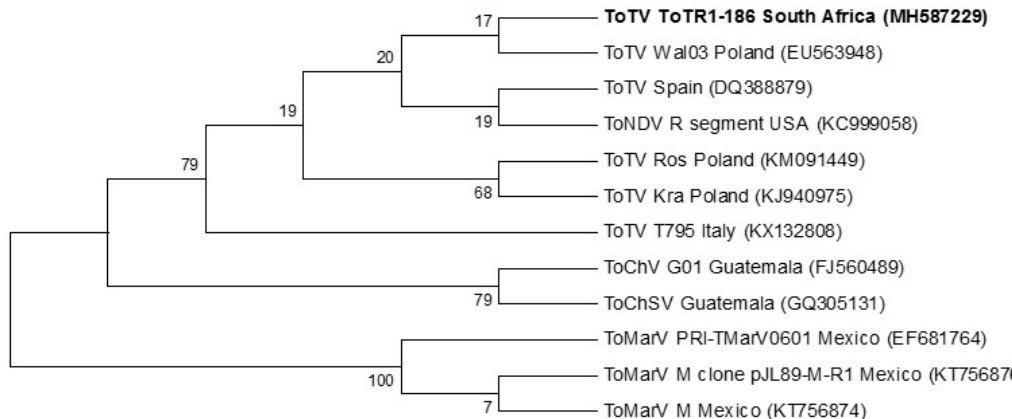
Figure 5. Phylogenetic relationship of the ToTV RNA-1 polyprotein from South Africa (ToTR1-186) in conjunction with all other tomato-infecting torradovirus isolates to date. Evolutionary analysis was inferred using the Maximum likelihood method and 1000 bootstrap replicates based on the General Time Reversible model [23]. Accession numbers are in parenthesis.